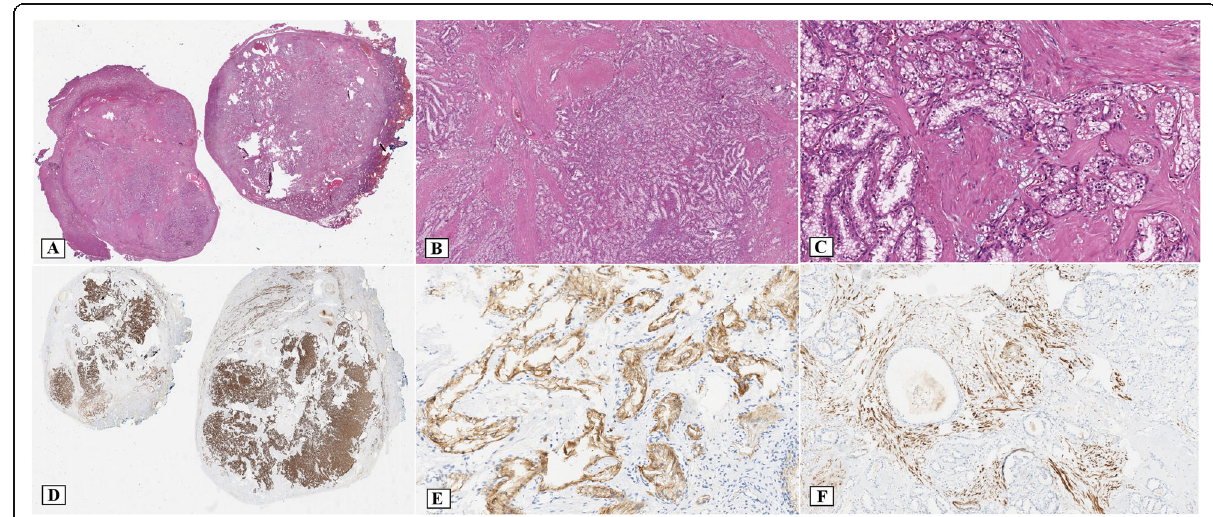
Fig. 8 Renal cell carcinoma with leiomyomatous stroma (RCCLMS). A tumor intermixed epithelial and stromal components ( a HE, 2x). Low-grade clear cells growing in tubular pattern separated by abundant stroma with smooth muscle differentiation ( b HE, 40x and c HE, 100x). Cytokeratin 7 expression is strong and diffuse ( d 2x) and carbonic anhydrase IX shows membranous expression ( e 100x). The surrounding stroma is reactive for desmin ( f